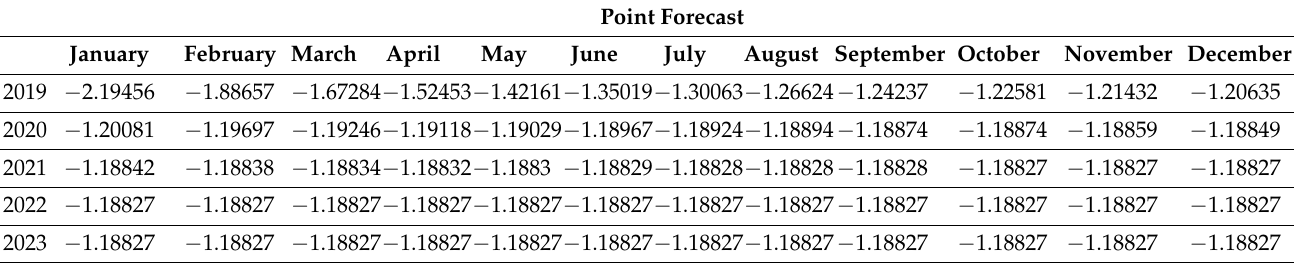
Table 16. Point forecasted value of SPEI-6 for five years. Point Forecast